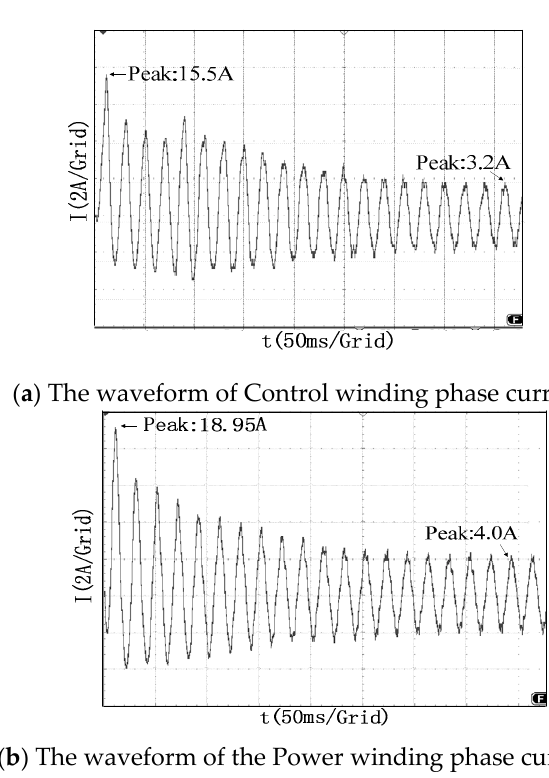
Figure 17. Test waveforms of stator winding phase current of BDFM prototype (mode 1).